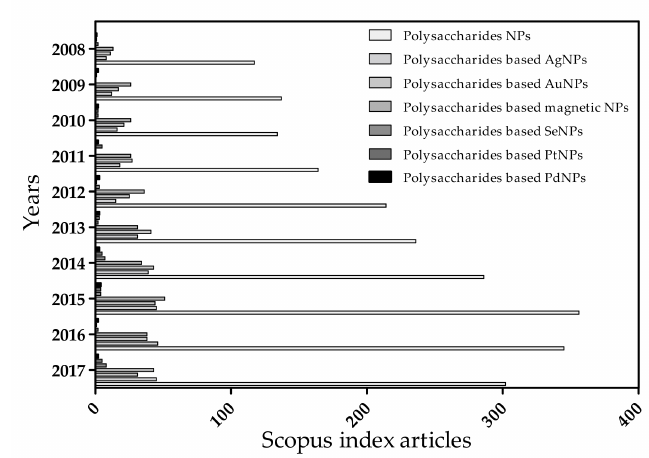
Figure 1. Scopus-indexed articles for polysaccharide based nanoparticles (NPs) and metallic nanoparticles (MNPs). (Archived until 6 November